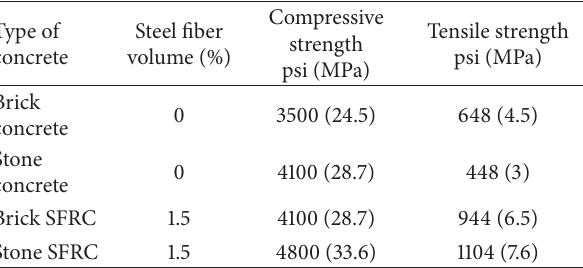
Table 1: Engineering properties of